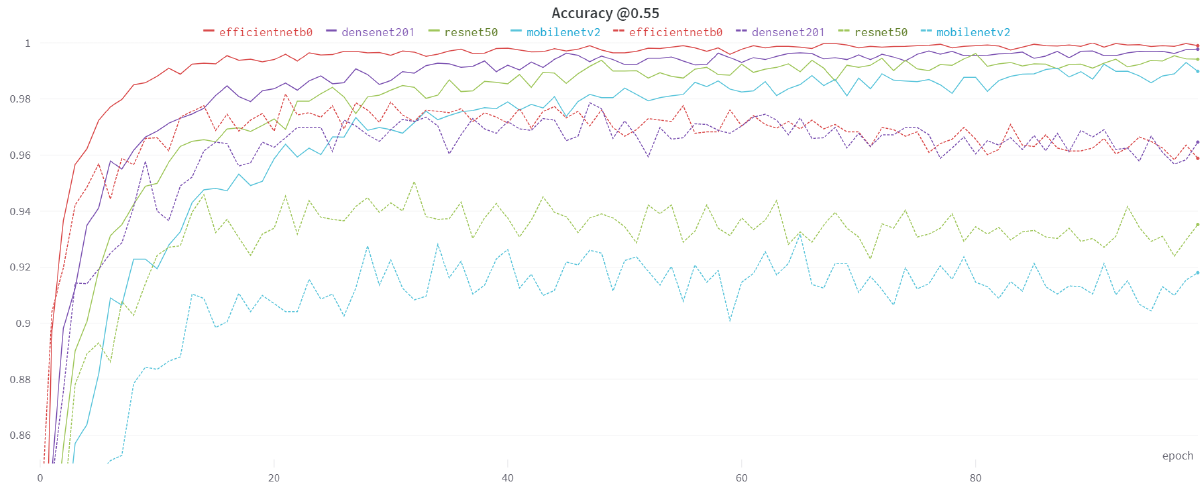
Figure 12. Comparison of the accuracy among ResNet50, DenseNet, MobileNetV2, and EfficientNet- B0 with a threshold score of 0.55.